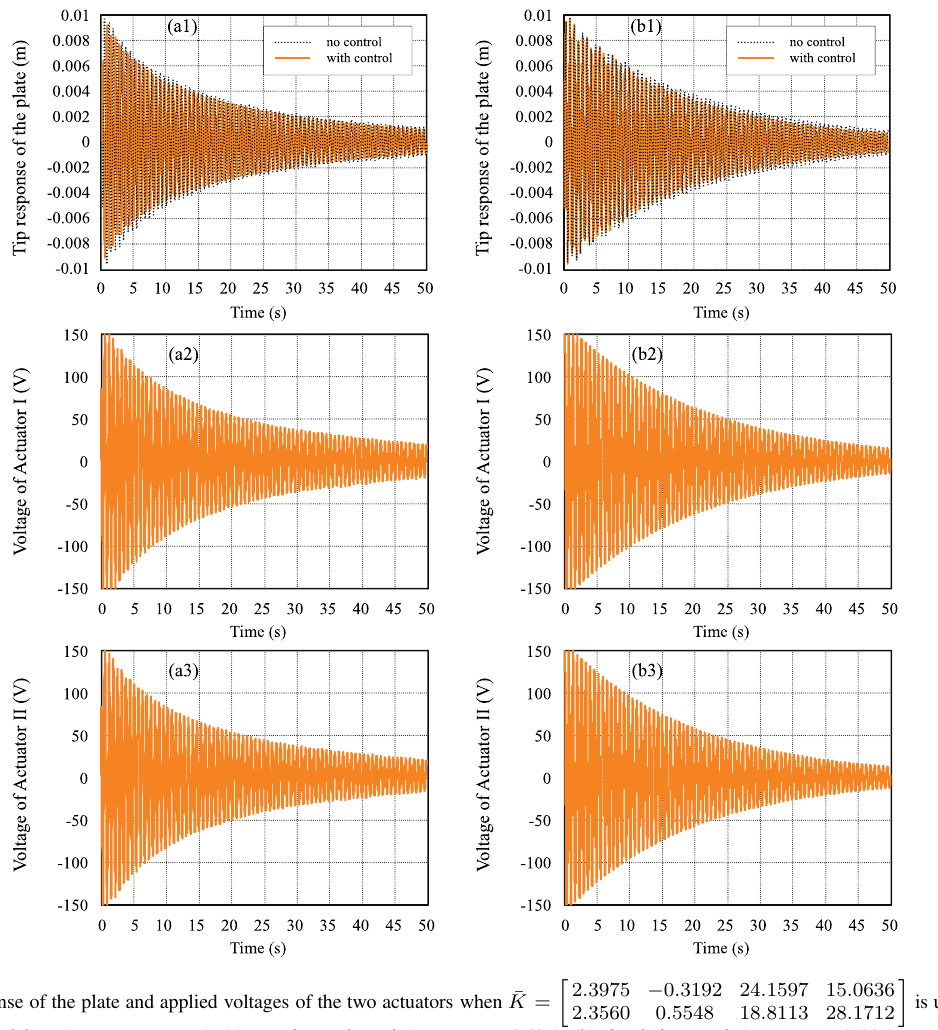
Fig. 14. Response of the plate and applied voltages of the two actuators when ¯ K =